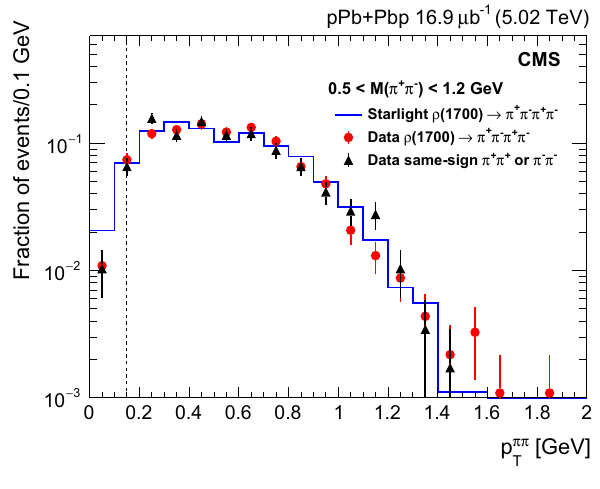
+ − π Fig. 1 Comparison between the p π distributions of the recon- T structed ρ ( 1700 ) mesons in the data (full symbols) and the starlight simulation (histogram) when only two oppositely charged pions are selected. The triangles correspond tosame-sign two-track events (either π + π + or π − π − ) in the data; they mostly come from ρ ( 1700 ) decays with two undetected pions. The integrals of all three distributions are normalized to unity. Vertical bars correspond to the statistical uncer- tainties. The region to the left of the dashed vertical line is not included in the analysis (see Sect. 5 for details)